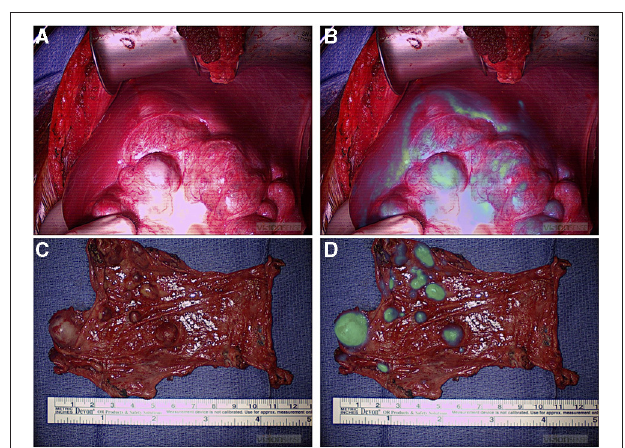
FIGURE 1 | NIR-guided localization of pulmonary metastases for three thoracoscopic resections from a hepatic primary tumor. (A,B) NIR localization of a superficial nodule. This nodule was seen with both standard of care white light (A) and NIR (B) . NIR, near infrared. (C,D) NIR localization of a 2cm nodule seen on the preoperative CT scan, but not visible when seen by standard of care white light (C) . (D) The same deep nodule was localized with NIR. NIR, near infrared; CT, computed tomography. (E,F) A small 0.2cm nodule not localized with preoperative CT scan or with standard of care white light/tactile feedback (E) . (F) The same nodule localized by NIR. NIR, near infrared.